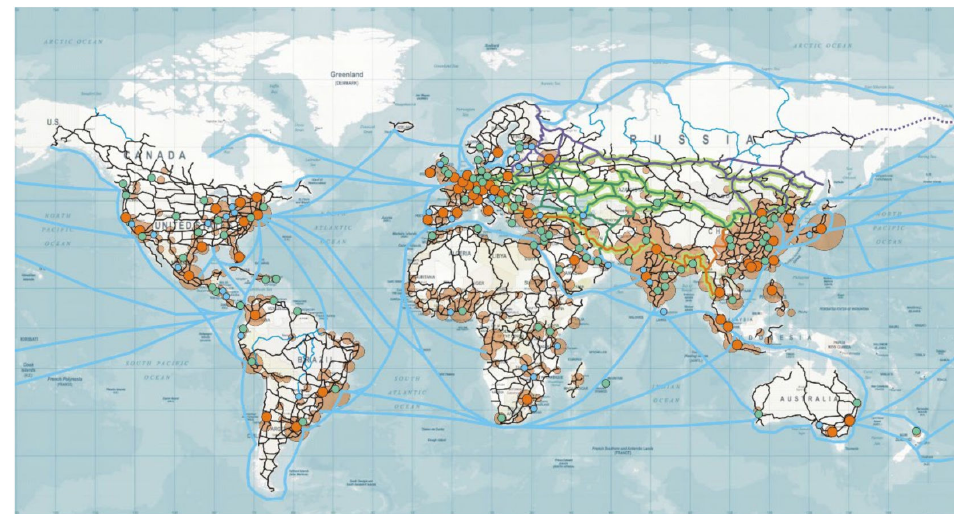
Figure 12. A model of the relationship of Eurasian transcontinental links in the world transport system, world cities according to GaWC and the system of megaregions (built on the basis of a forecast model according to UN